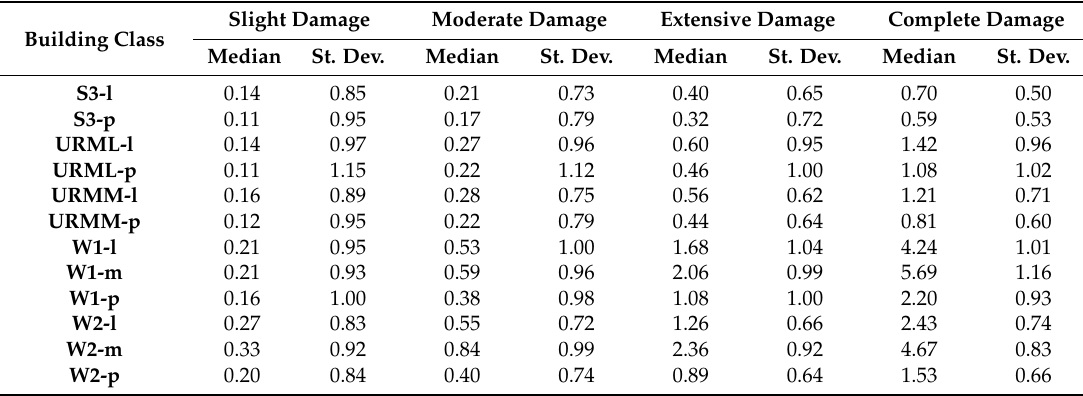
Table A4. Median and standard deviation for buildings classes for short strong motion duration (M ≤